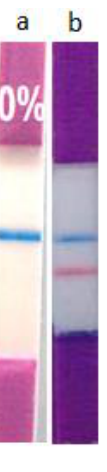
Figure 5. Immunochromatograms from the collected fraction corresponding to the signal of interest at 10.8 min by HPLC of an adulterated sample, ( a ) Absence of recognition of cGMP in the sample negative control, only the blue control line was observed; fresh milk without adulteration (0%) and ( b ) Presence of cGMP in the 5% cGMP sample; recognition of the monoclonal antibodies located on the strip (Immunostick) of cGMP present in the collected fraction for the signal of interest. The blue control line and the positive test red line were observed.